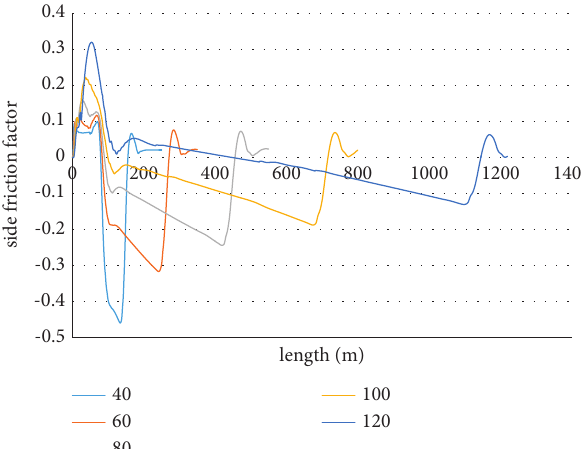
Figure 9: Comparison of the coefficient of friction along the route at different vehicle speeds. Table 3: Percentage of changes in coefficient of friction on slope state of − 4% and wind speed of 16 km/h. Figure 7: Comparison of coefficient of friction along the path at